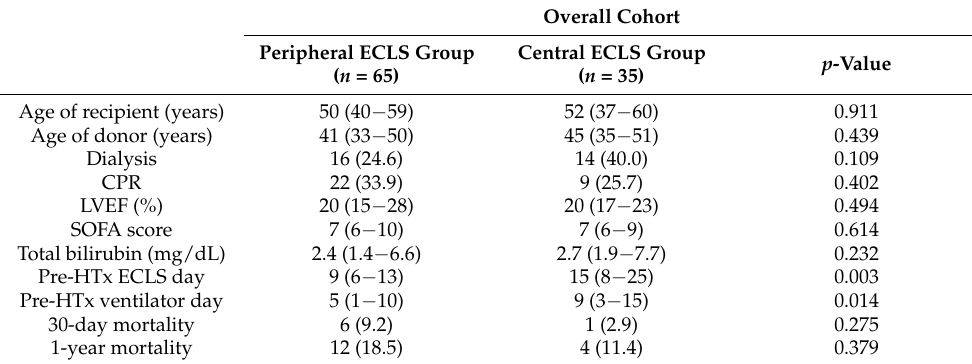
Table 4. Subgroup analysis of the ECLS group according to the cannulation